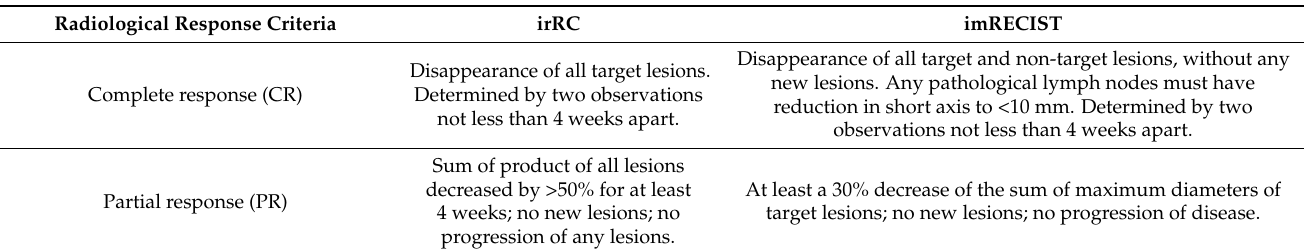
Table 3. Summarized the radiological and functional response criteria to the immunotherapy in tumor. Radiological Response